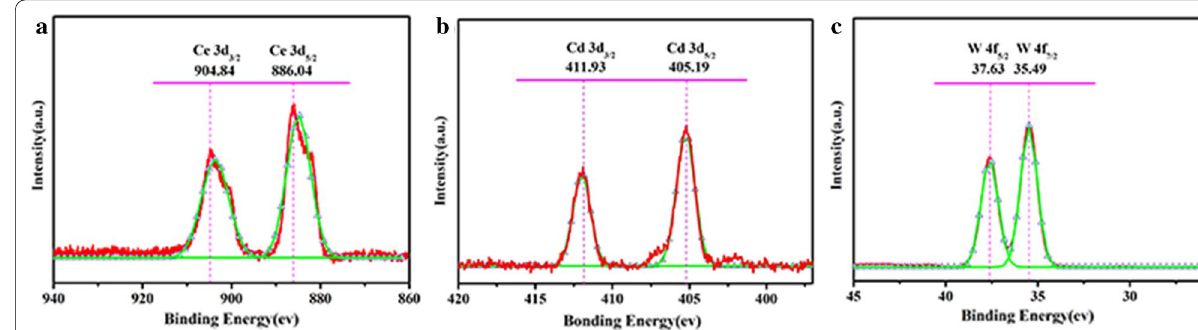
Fig. 10 XPS spectra of CeCdW 12 nanoflowers: a Ce 3 d ; b Cd 3 d ; c W 4 f